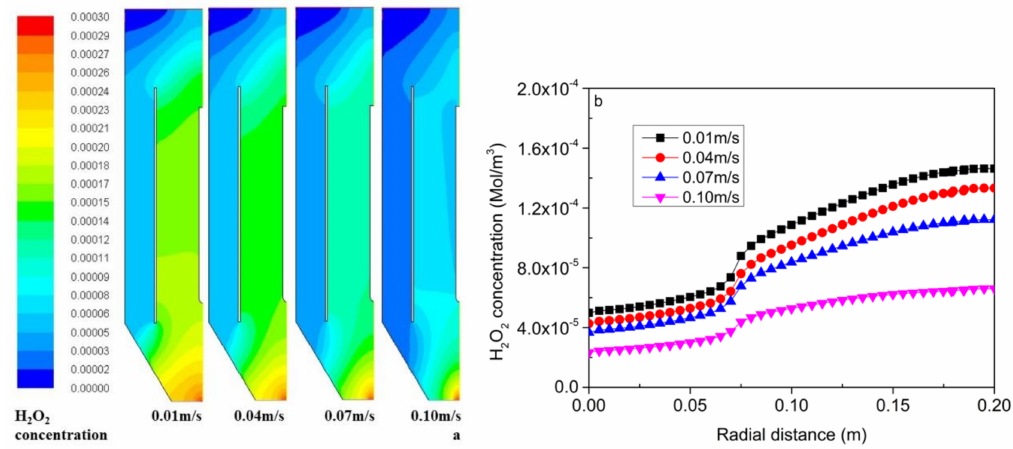
Figure 6. The contours ( a ) and the radial distribution ( b ) of molar concentration of H 2 O 2 at di ff erent gas velocity in Section